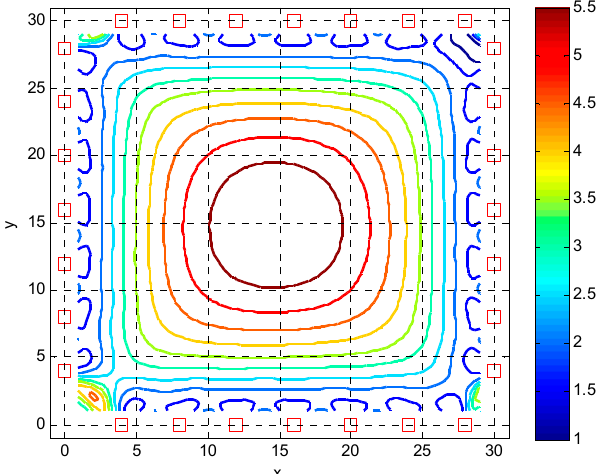
  , J x y with red xx MWD MWD